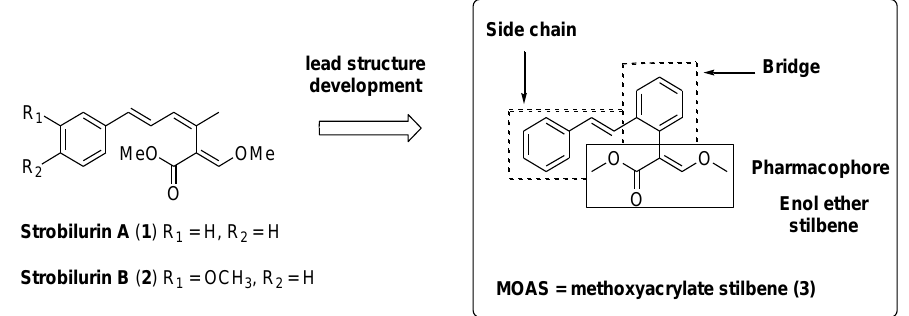
Figure 2. Structure of natural strobilurin A and B, and the methoxyacrylate stilbene (MOAS) lead structure.